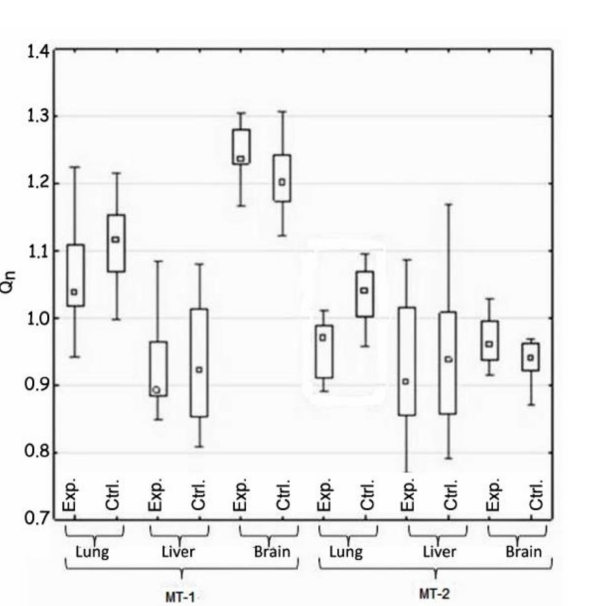
Figure 1. Comparison of the expression of MT-1 and Mt-2 genes in the control and test groups (H1).